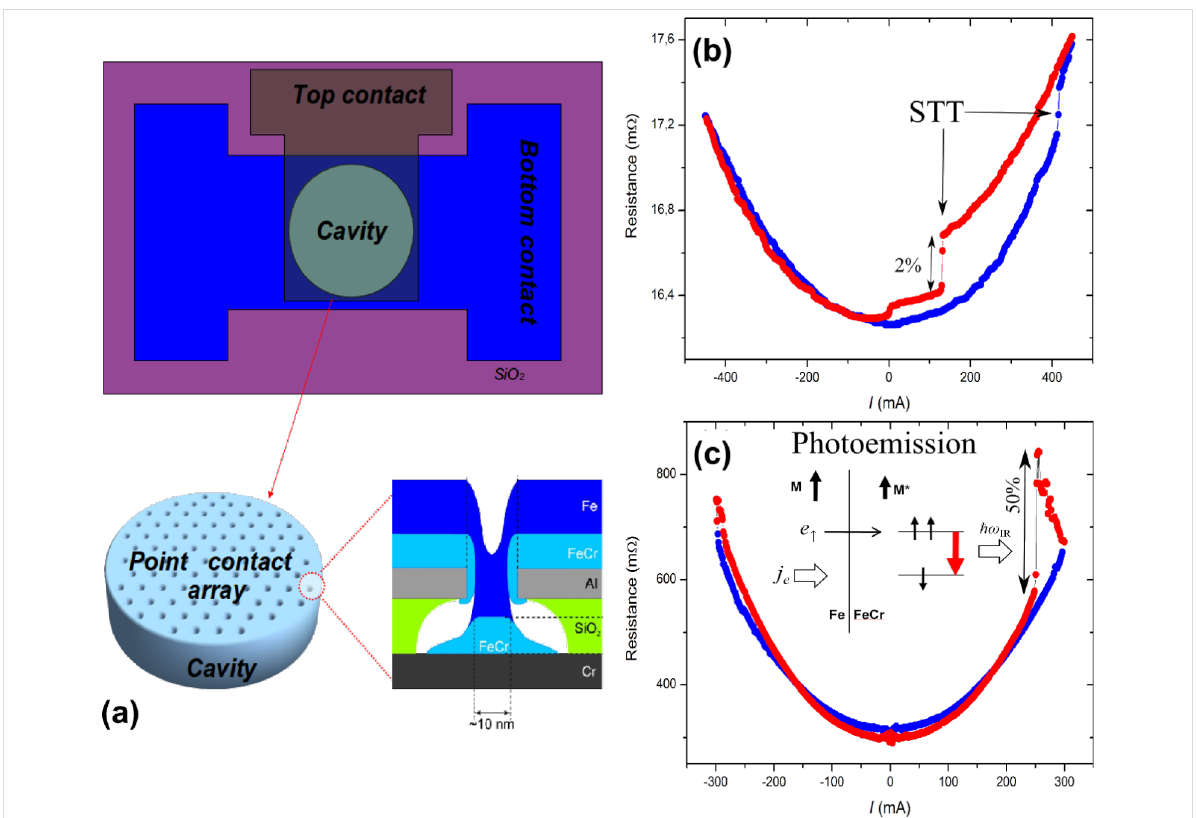
Figure 5: (a) ) Illustration of the integrated circuit device produced by using a colloidal nanoarray mask and three steps of photo-lithography for the bottom electrode, top electrode, and the resonator. Top panel shows the layout of the device, with the top electrode formed in the shape of a photon resonator for IR–terahertz, 10–50 µm diameters. Bottom panel shows the nano-array mask and the core structure of a single sub-10 nm point contact. (b) Resistance versus bias-current characteristic for a Fe/Fe 0.7 Cr 0.3 point-contact array (low resistance range, 10–20 m Ω ), showing current-induced hysteretic switching superposed on to a parabolic phonon background. (c) Resistance versus bias-current for a 36 µm diameter spin-flip laser array (high-resistance limit, ≈ 1 Ω ), showing giant excitations of the threshold type at critical pumping, consistent with the onset of the expected stimulated emission in the device [15]. Red and blue represent up and down sweeps in bias. More details on these measurements can be found in